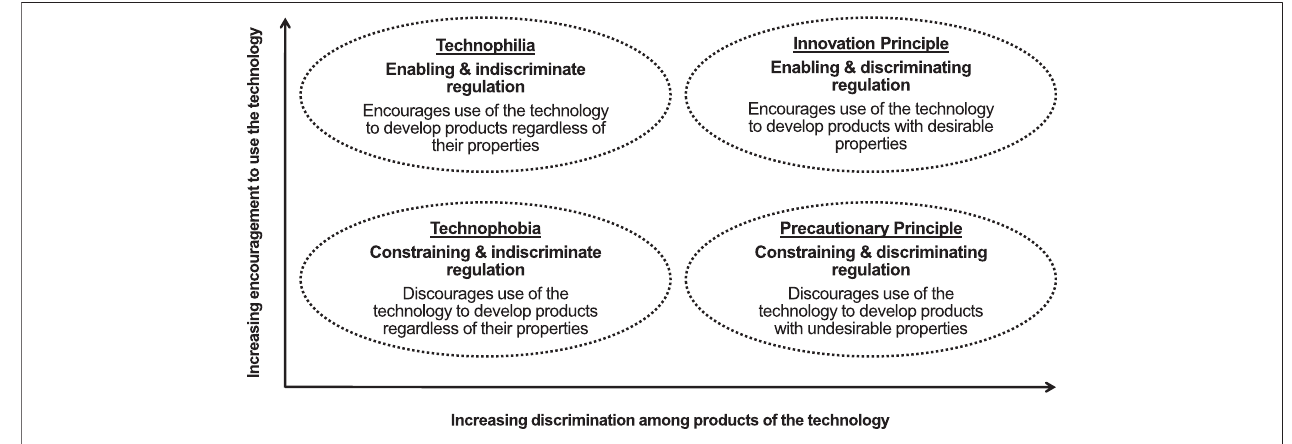
FIGURE 1 | A conceptual classi fi cation of approaches to regulation developed from Chataway et al. (2006) and Raybould (2019).